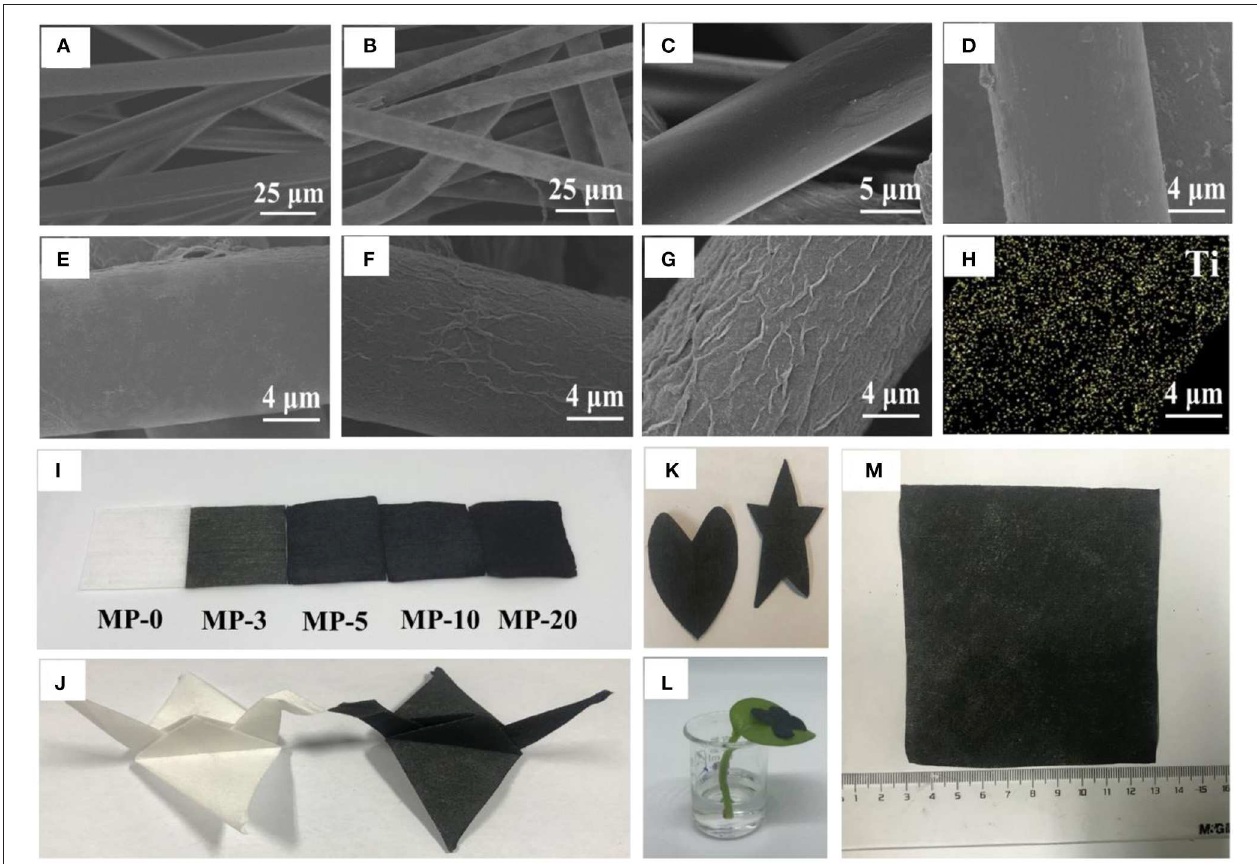
FIGURE 3 | SEM images of (A) the original air-laid paper and (B) MXene/air-laid paper composite; FE-SEM images of (C) the original air-laid paper and (D–G) MXene/air-laid paper composite (MP-3, MP-5, MP-10, and MP-20, respectively); (H) the corresponding EDS elemental mapping image of MP-20; (I) the digital images of composite papers; (J) the paper crane folded by original air-laid paper and MXene/air-laid paper composite; (K) the paper heart and paper star cut by MXene/air-laid paper composite; (L) the ultralight MXene/air-laid paper composite flower on a leaf; (M) the MXene/air-laid paper in large